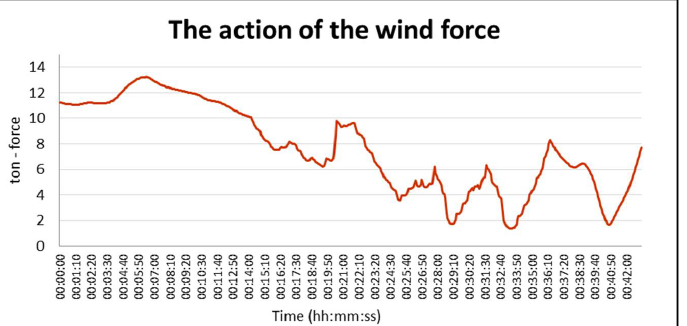
Figure 20. The force of wind pressure on the vessel’s hull for constant parameters of the weather zone (1 ton force = 9.80665 kN in SI system).